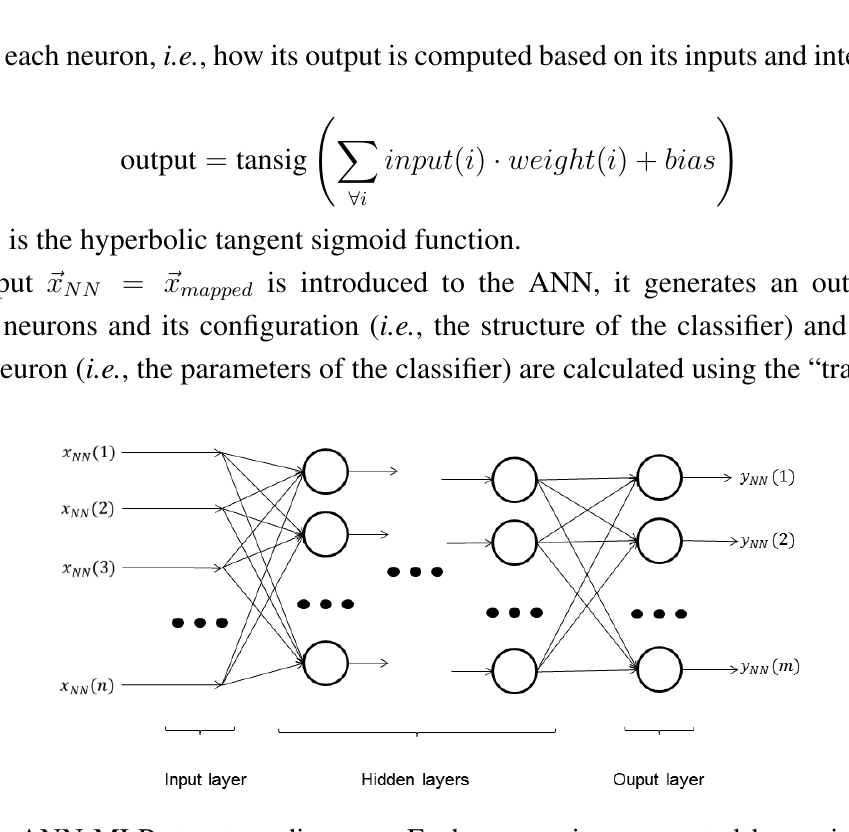
Figure 7. ANN-MLP structure diagram. Each neuron is represented by a circle, whose behavior is explained by Equation (6). The connections between the inputs, the neurons and the outputs are represented with